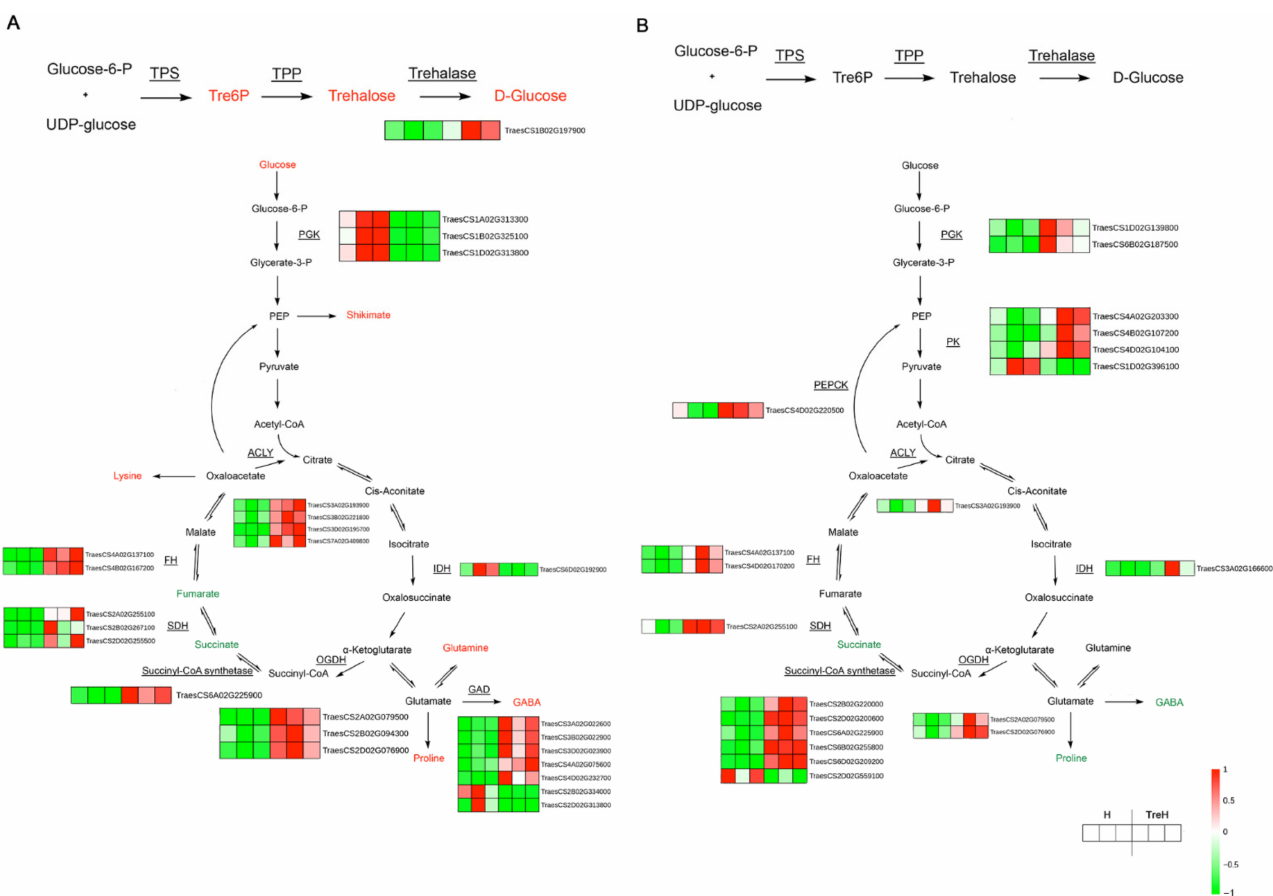
Figure 11. Gene-metabolite integrated analysis network of trehalose, amino acid and tricar- boxylic acid cycle (TCA cycle) metabolic pathways. ( A ) Map of Yangmai 18. ( B ) Map of Yannong 19. The red words represent the metabolites upregulated and the green words repre- sent the metabolites downregulated. The underlined genes were differentially expressed and their relative expression levels (FPKM value) in two groups (three biological replicates of each treatment) were shown as heat maps. H—heat stress treatment for 24 h; TreH—trehalose